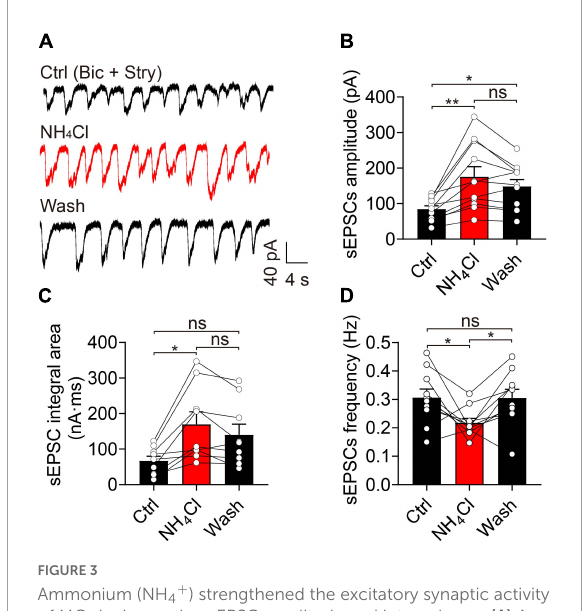
FIGURE3 Ammonium (NH 4 + ) strengthened the excitatory synaptic activity of MCs by increasing sEPSC amplitude and integral area. (A) An example of sEPSCs recorded in the voltage-clamp mode in the presence of Bic (10 µ M) and Stry (3 µ M, Ctrl), indicating increased amplitude and integral area after NH 4 Cl application, which are partially reversed by the wash solution. (B–D) sEPSC amplitude, frequency, and integral area in Ctrl, NH 4 Cl, and wash solution, respectively. Error bars represent standard error; * p < 0.05, ** p < 0.01; ns, not significant; one-way ANOVA with LSD post-hoc